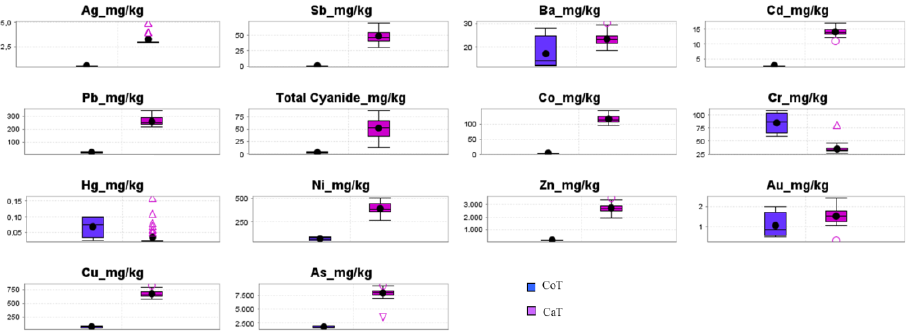
Figure 4. Basic statistics and comparison of trace element (mg/kg log) for the two sets of tailings samples.